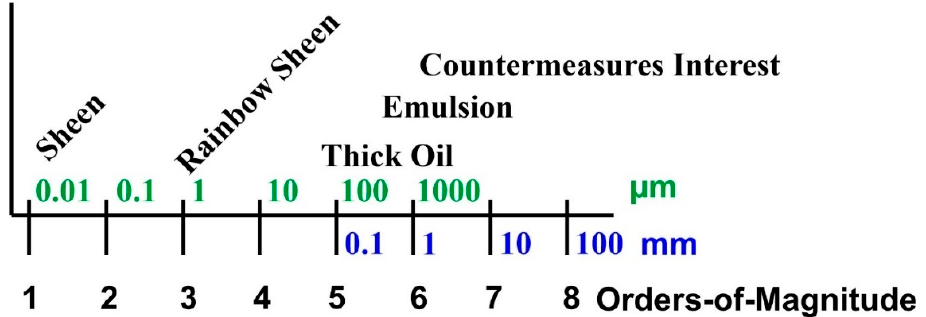
Figure 3. Thicknesses of interest to the spill responder .